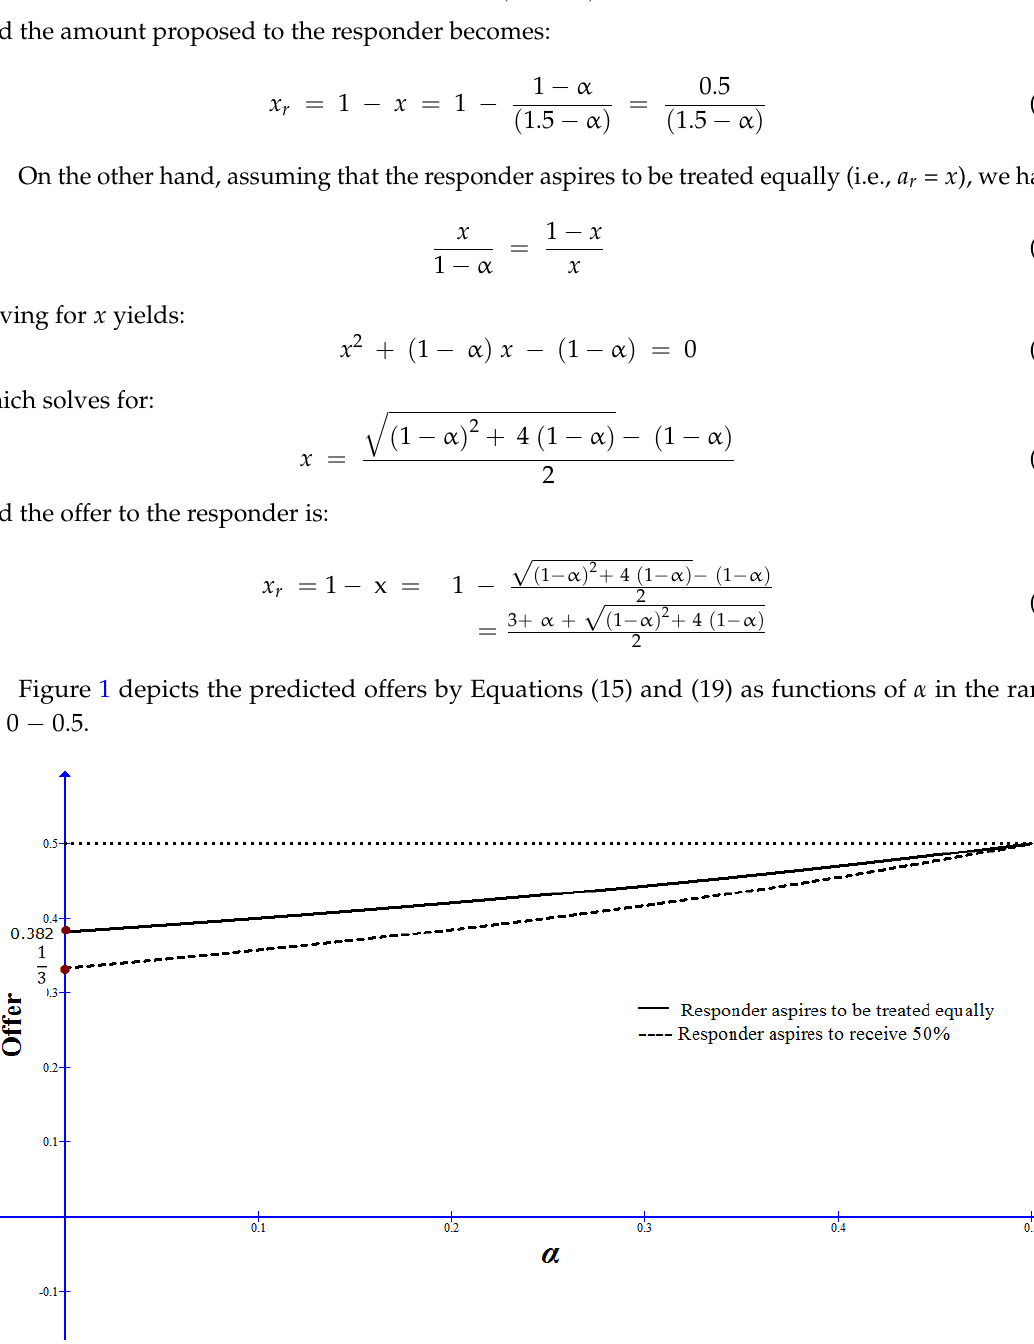
Figure 1. Predicted offers as a function of the proposer’s security level.